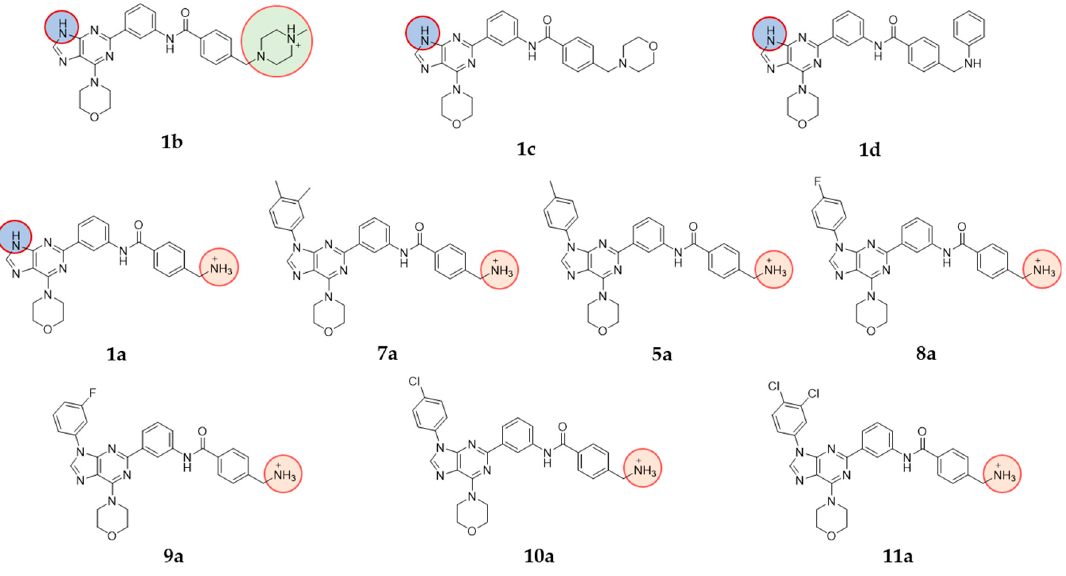
Figure 7. Set of selective ligands found for PI3K γ .